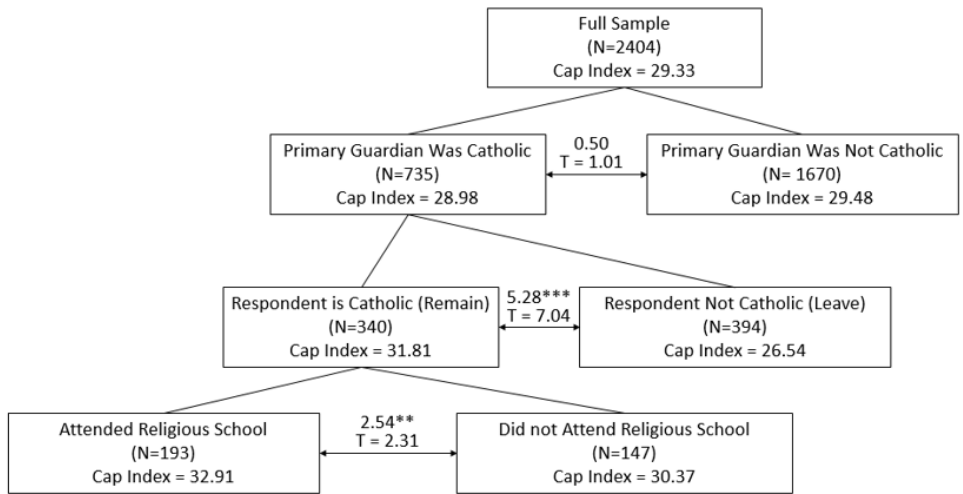
Figure 1. Capitalism index by subsample. The number next to connecting arrows represents the difference in subgroups Capitalism index scores, and asterisks indicate the level of statistical significance from a t -test. ** p < 0.05, and *** p < 0.01